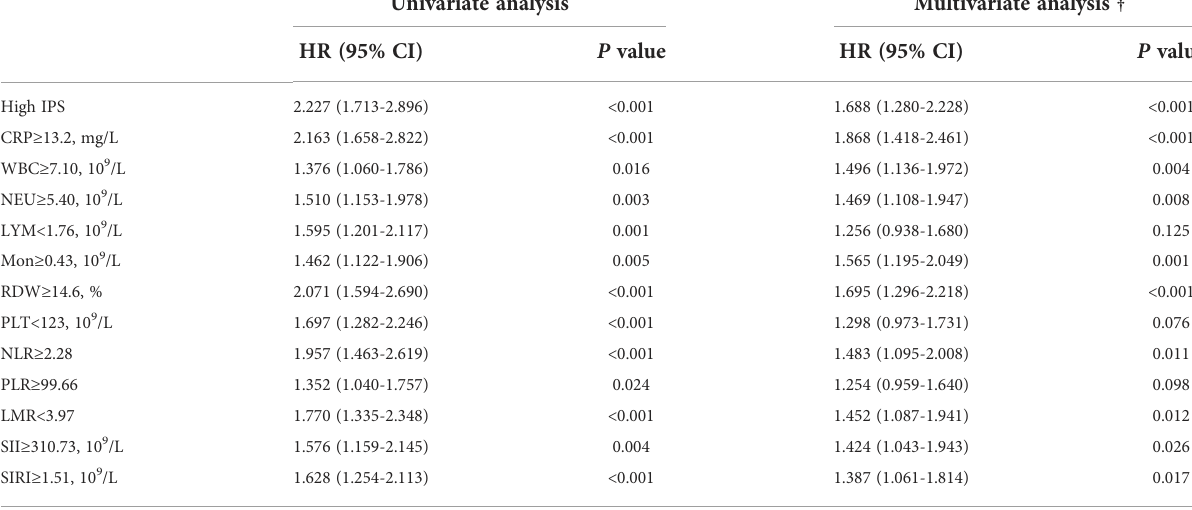
TABLE 4 Association of in fl ammatory biomarkers with all-cause mortality in patients with